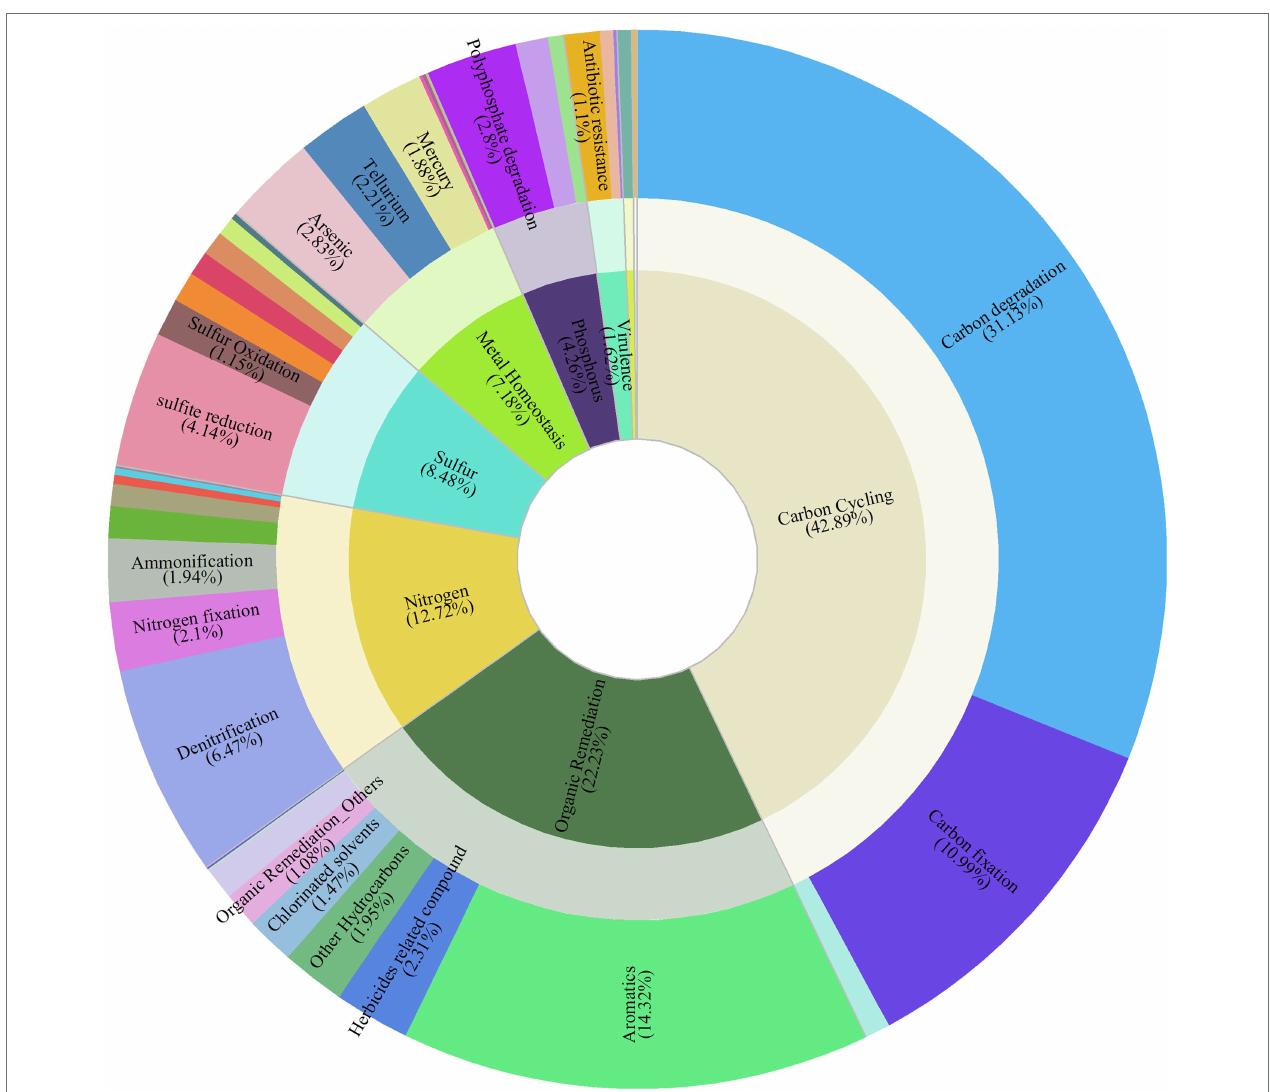
FIGURE 1 | Composition of functional gene categories and gene subcategories. The inner circle represents the gene category; the outer circle represents the gene